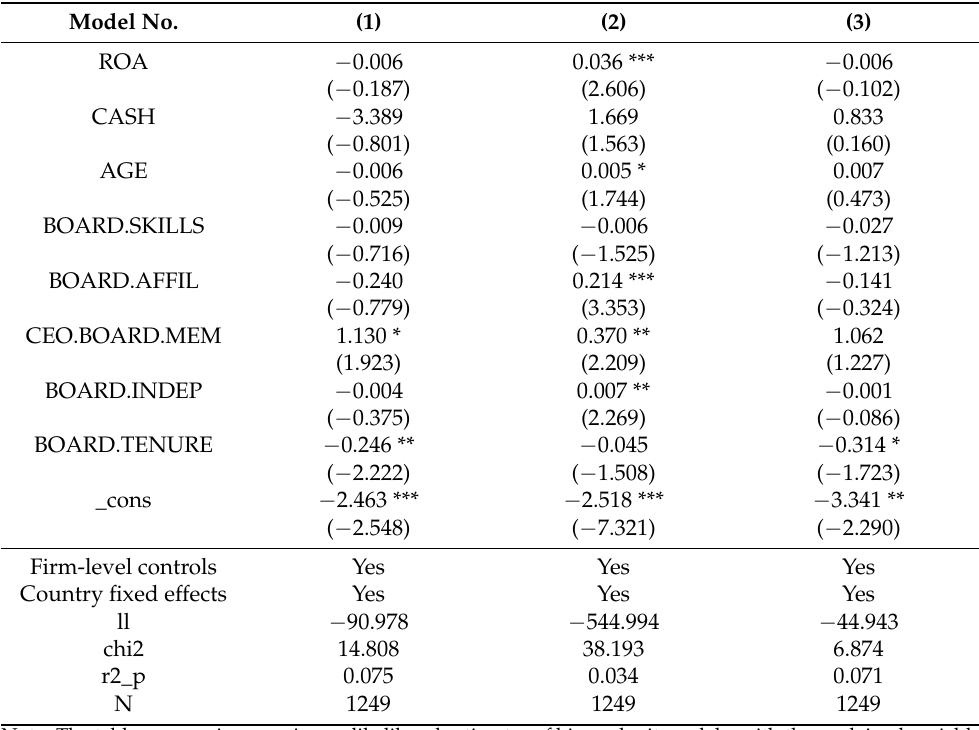
Table 5. Acquirer characteristics and deal details: cross-sectional comparison depending on target type. Model No.